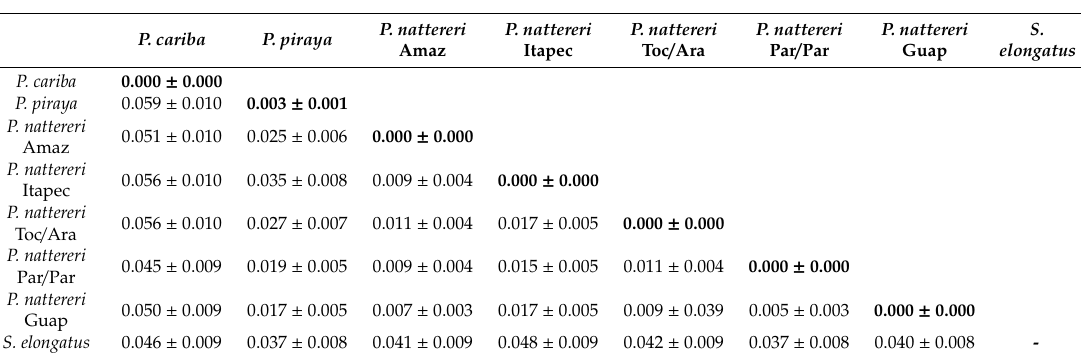
Table 1. Pairwise TN93 genetic distance values among drainage-based lineages of Pygocentrus . Bold numbers represent intraspecific genetic variation. Amaz = Amazonas; Itapec = Itapecuru; Toc / Ara = Tocantins / Araguaia; Par / Par = Paran á / Paraguay; Guap = Guapor é